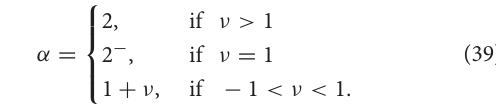
FIGURE 2 | Plot of the correlation function R ( t ) for normal diffusion ( ν Here, γ 1 and ω s 2 and 20, for curves a and b , respectively. Curve c is = = γ t ). Note that curves b and c are indistinguishable, except the plot of exp ( − near the origin (see inset). Inset: Plot of curves b , c and cos ( ω 0 t ), near the origin. From Vainstein et al. [1], with permission from Europhysics